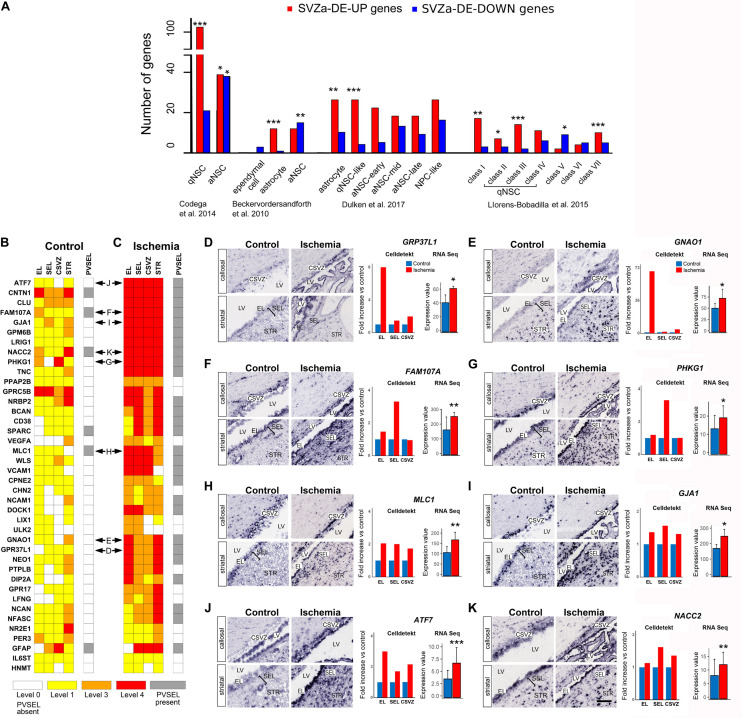
Prevalence of transcripts characteristic for quiescent NSCs in ischemic SVZa. (A) Monkey total SVZa genes or SVZa-DE genes were compared with the gene datasets enriched in mouse SVZ progenitors (Beckervordersandforth et al., 2010; Codega et al., 2014; Llorens-Bobadilla et al., 2015; Dulken et al., 2017). The enrichment for each of the progenitor transcription profiles in monkey SVZa-DE genes was statistically analyzed. Monkey genes that correspond to each progenitor type are listed in Supplementary Tables S9–S12. * Fisher’s exact test p-value < 0.05; ** Fisher’s exact test p-value < 0.01; *** Fisher’s exact test p-value < 0.001. (B,C) Comparative heat maps of 40 genes from the “monkey-niche.org” database which are found in the datasets of Codega et al., 2014; Dulken et al., 2017; Llorens-Bobadilla et al., 2015. Horizontal double arrows refer to ISH data shown in (D–K). (D–K) ISH data, Celldetekt-based quantification of ISH and RPKM based quantification revealed a region-specific strong post-ischemic enhancement in the EL (D, GPR37L1; E, GNAO1) or in the SEL (F, FAM107A; G, PHKG1). Other genes (H–K) were enhanced in EL, SEL and CSVZ (MLC1, GJA1, ATF7, and NACC2). Gene expression was quantified (right column) using Celldetekt and transcriptomic data as described in Figure 3. See Supplementary Table S1 for atlas coordinates of the sections shown in panels (D–K). Scale bar 100 μm.